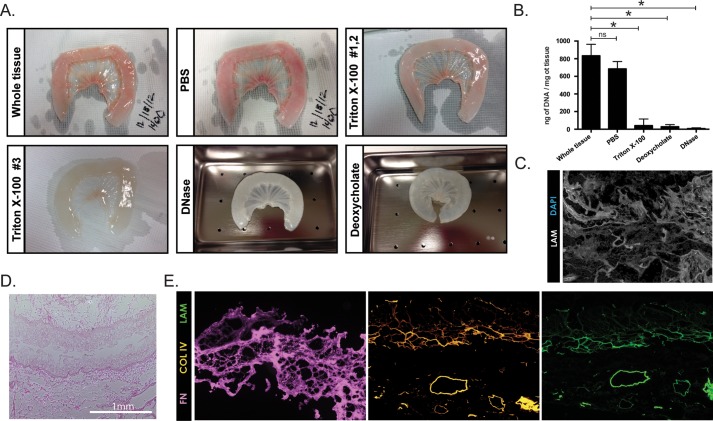
Decellularization of porcine small intestine. (A) Porcine small intestine is shown starting from whole tissue and then after subsequent stages of the decellularization protocol resulting in the final acellular matrix that has a translucent appearance. (B) Small pieces of porcine intestine were collected at various stages of the decellularization protocol to measure DNA content confirming that the protocol successfully removes existing DNA as there is a significant reduction after the detergent washes and then the DNA content reaches zero by the final step of DNAse treatment. N=3 for each group. *P<0.05 based on an unpaired t-test using Welch's correction, error bars represent s.e.m. (C) Porcine matrix was DAPI stained to confirm a lack of nuclei and co-stained with laminin to outline the matrix. (D) Hematoxylin and eosin staining of a cross section of the matrix shows the preservation of the matrix structure with finger-like projections into the lumen, which presumably represent the inner extracellular matrix cores of what were previously villi. Scale bar: 1 mm. (E) Serial cross sections of matrix were stained for extracellular matrix proteins to further confirm the integrity of the acellular matrix. Collagens and laminin are still present even after decellularization suggesting the decellularization process does not remove all extracellular matrix proteins.